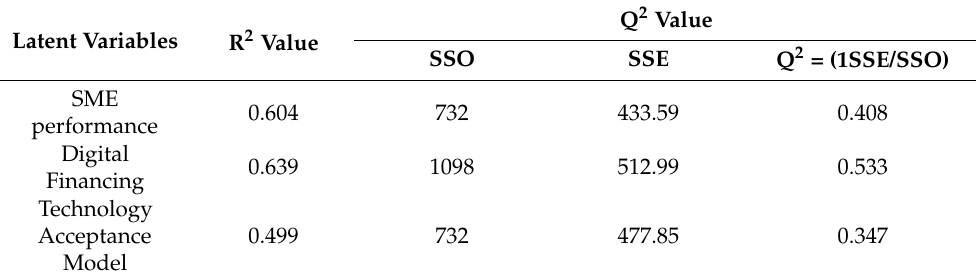
Table 7. Coefficient of determination (R 2 ) and predictive relevance (Q 2 ) results.